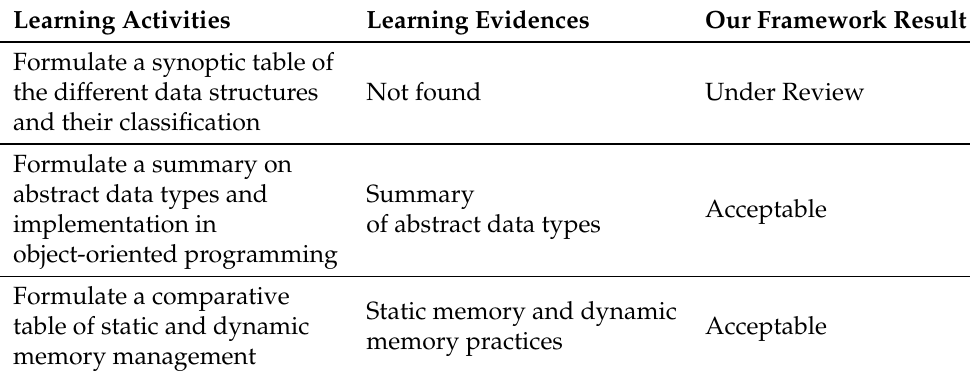
Table 5. Evidence associated with learning activities.